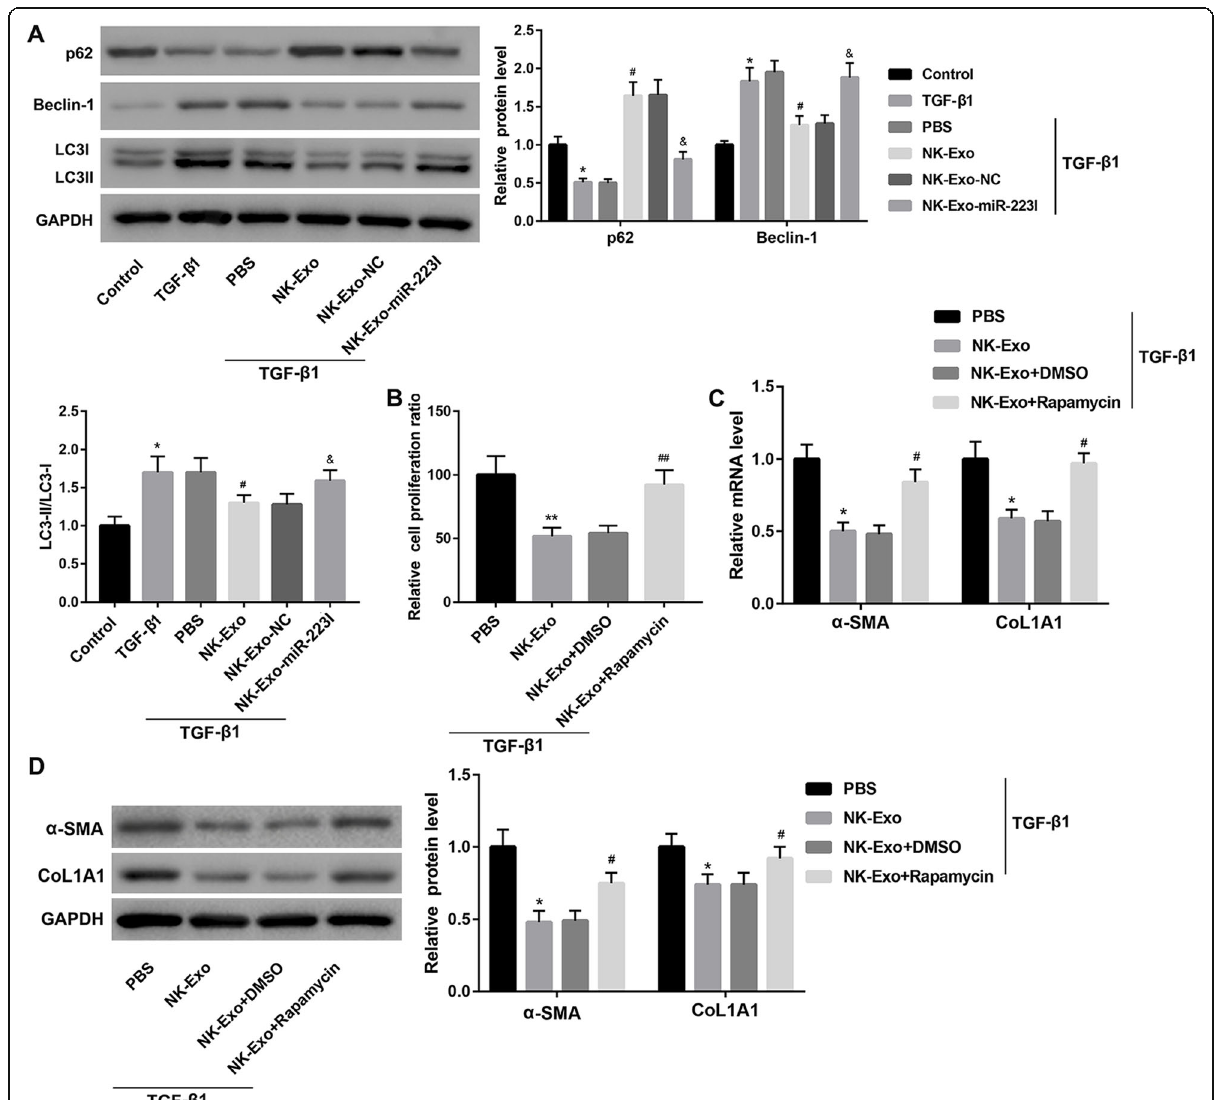
Fig. 2 NK-Exo-mediated transfer of miR-223 attenuated TGF- β 1-induced HSC activation by inhibiting autophagy. a The protein levels of autophagy-related proteins including p62, Beclin-1, LC3-I, LC3-II in LX-2 cells in the groups of Control, TGF- β 1, TGF- β 1 + PBS, TGF- β 1 + NK-Exo, TGF- β 1 + NK-Exo-NC, and TGF- β 1 + NK-Exo-miR-223I. * P < 0.05, vs. Control; # P < 0.05, vs. TGF- β 1 + PBS; & P < 0.05, vs. TGF- β 1 + NK-Exo-NC. Cell proliferation ratio determined by CCK-8 assay (b) , the mRNA (c) and protein (d) levels of α -SMA and CoL1A1 in LX-2 cells in the groups of TGF- β 1 + PBS, TGF- β 1 + NK-Exo, TGF- β 1 + NK-Exo + DMSO and TGF- β 1 + NK-Exo + rapamycin. * P < 0.05, ** P < 0.01 vs. TGF- β 1 + PBS; # P < 0.05, ## P < 0.01 vs. TGF- β 1 + NK-Exo + DMSO. The data are presented as the mean ± standard deviation (n =